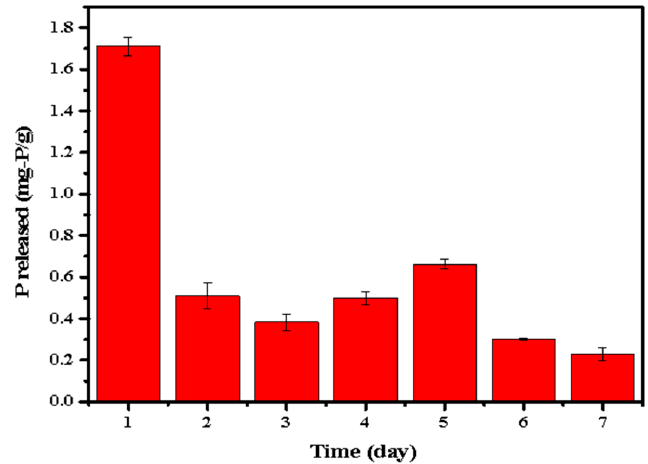
Figure 13. Successive and repeatable release of